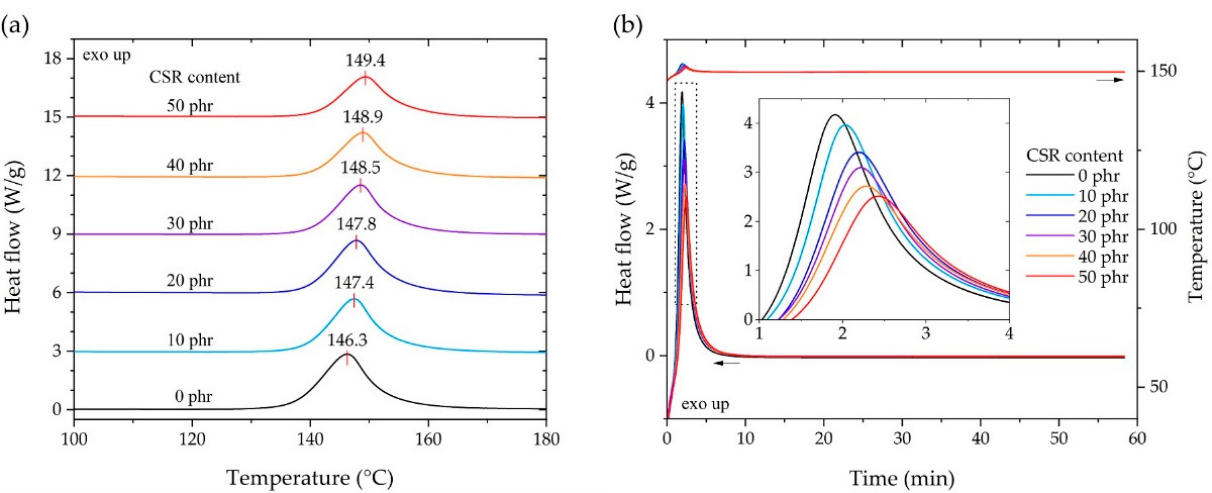
Figure 3. Exothermic curing reaction of the differential scanning calorimetry (DSC) results according to the content of CSR nanoparticles. ( a ) Temperature sweep from 50 to 250 °C at a constant heating rate of 5 °C/min. ( b ) Isothermal heat flow behaviors at 150 °C.